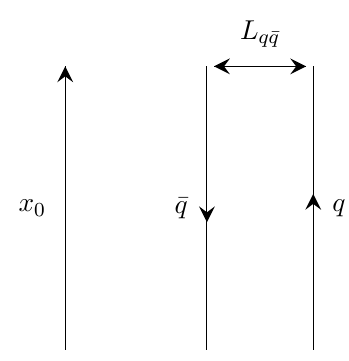
Figure 3 . A quark-antiquark pair at a distance L q (cid:22) q from each